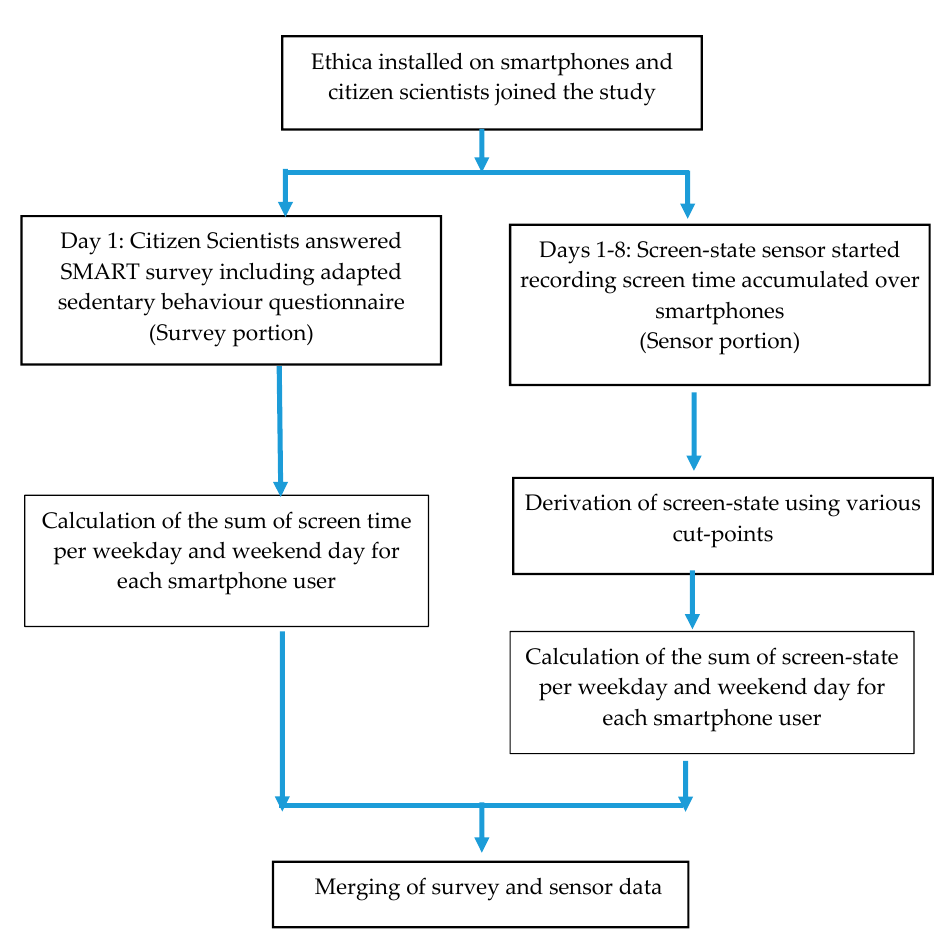
Figure 4. Stages of methodology development .